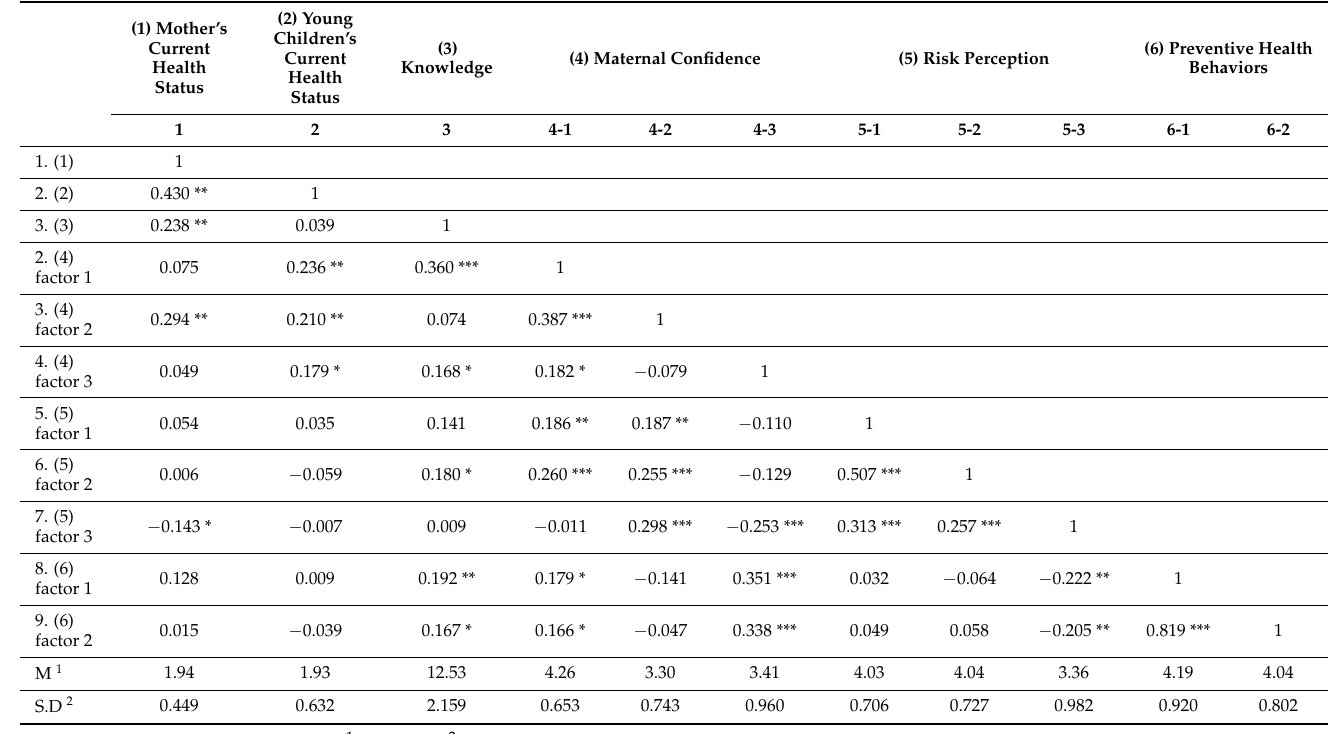
Table 2. Correlation between mother’s and young children’s current health status, knowledge, maternal confidence, risk perception, preventive health behaviors of